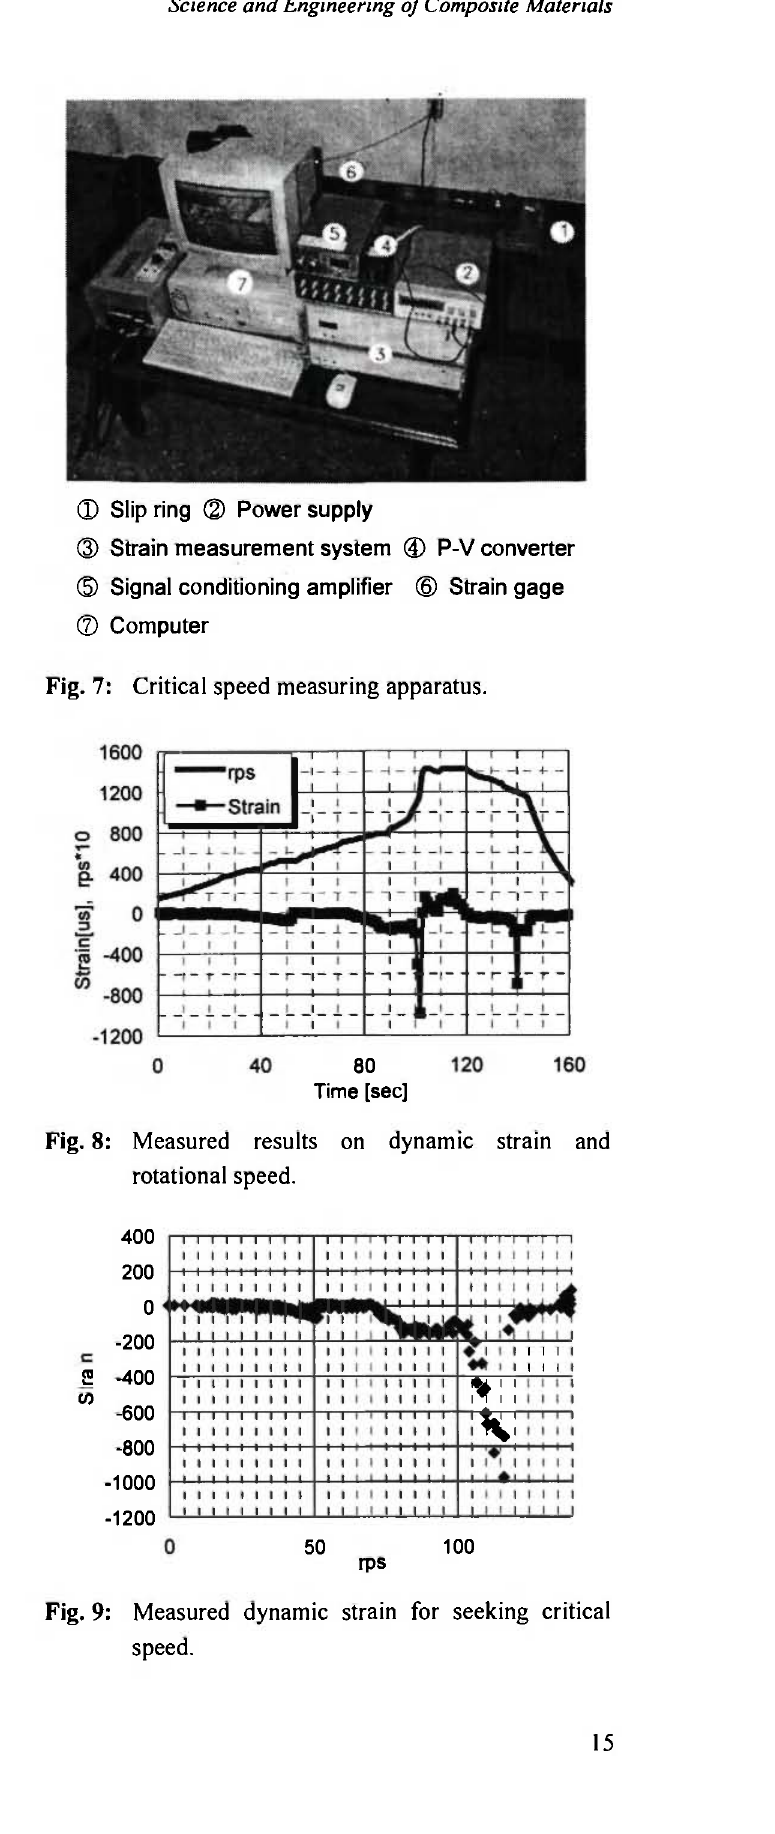
Fig. 7: Critical speed measuring apparatus.